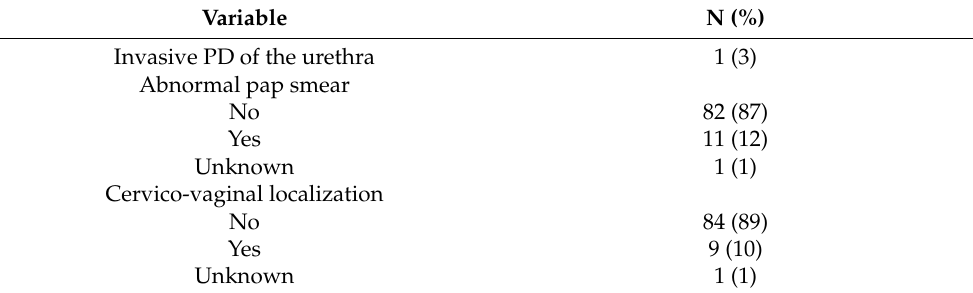
Figure 1. Overall survival of women affected by vulvar EMPD (N = 93).